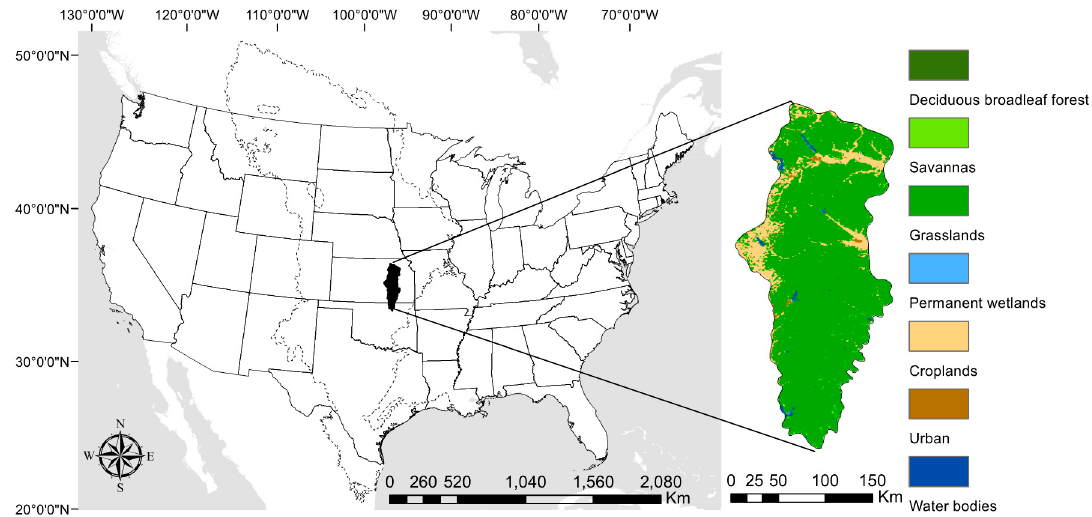
Figure 1. The Great Plains of North America (dotted line) extending from Mexico to Canada with the Flint Hills ecoregion shaded black [33] occurring mostly in the state of Kansas and the oceans in gray. The political state boundaries are also added for convenience. The MODIS land cover product MCD12Q1 (collection 6) is displayed on the right showing the grassland-dominant landscape.